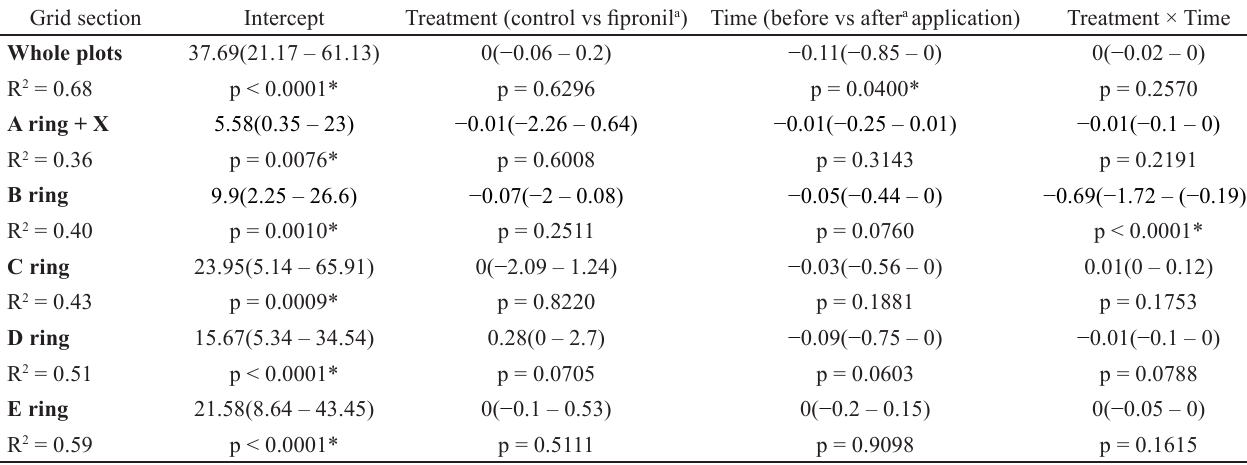
Table 1 . Results of mixed-effects multiple linear regression models for differences between control and fipronil-treated experimental grids based on the mean number of termites collected per station. Parameter estimates are displayed with their 95% confidence intervals. Parameter estimates and confidence intervals were back-transformed before including them in this table. For the interaction term, positive parameter estimates imply higher percentages of stations occupied by H. aureus relative to controls after treatment, while negative values imply a decrease. Only fixed effects are